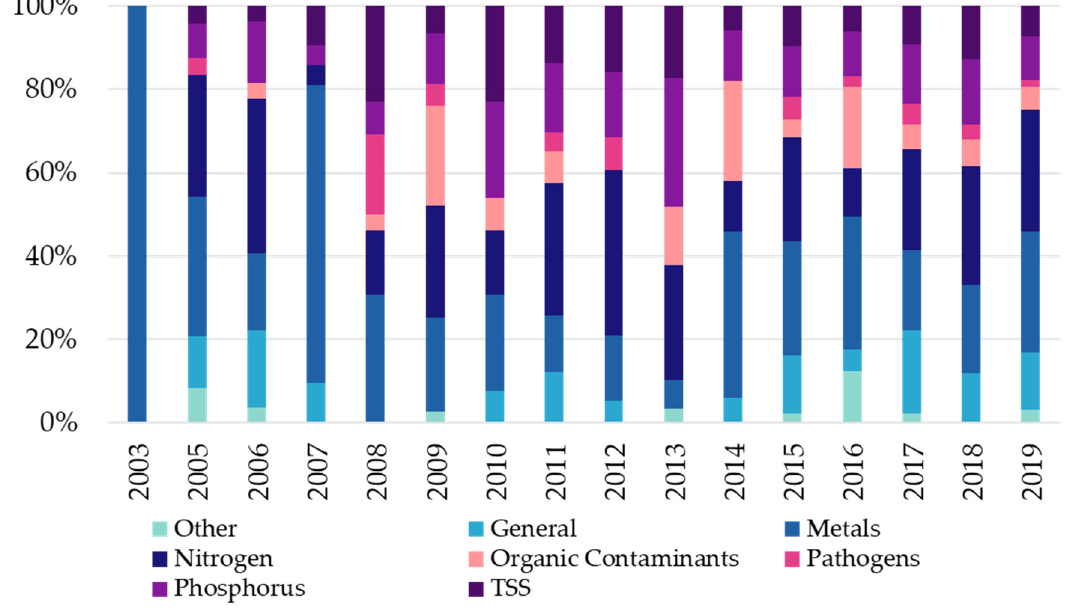
Figure 11. Breakdown of contaminant transport and fate studies by pollutants.